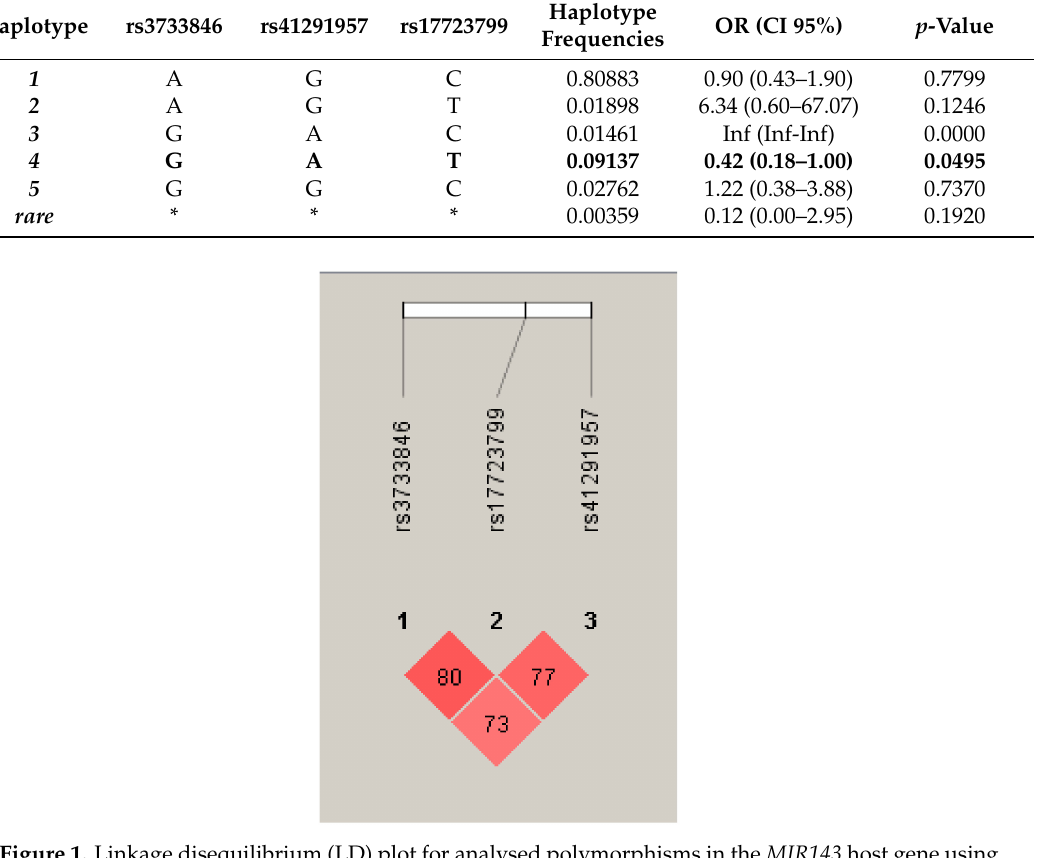
Figure 1. Linkage disequilibrium (LD) plot for analysed polymorphisms in the MIR143 host gene using Haploview software version 4.2 (Daly Lab, Broad Institute, Cambridge, MA,